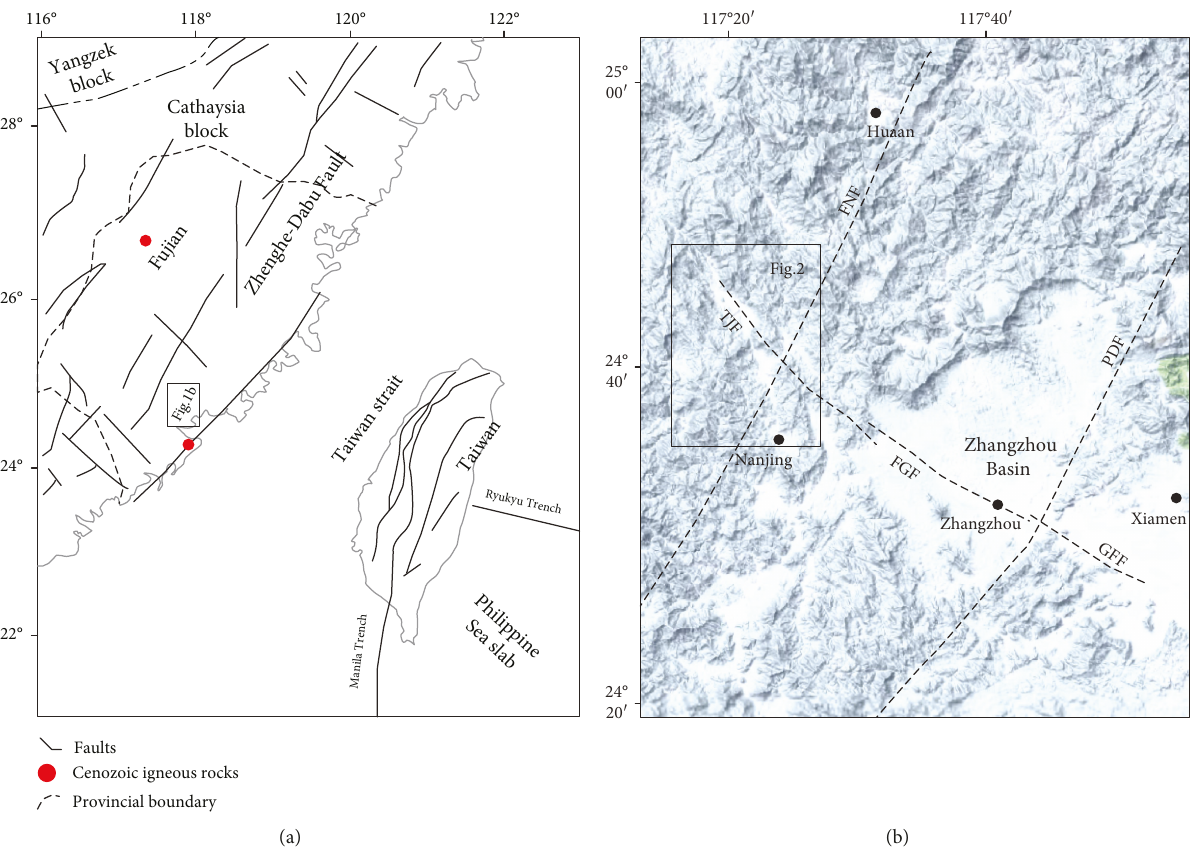
Figure 1: Tectonic location of the NZB (revised from [16]). FNF: Fuan-Nanjing Fault; TJF: Tianbao-Jinshan Fault; FGF: Fengle-Guanyinshan Fault; GFF: Guanyinshan-Fugong